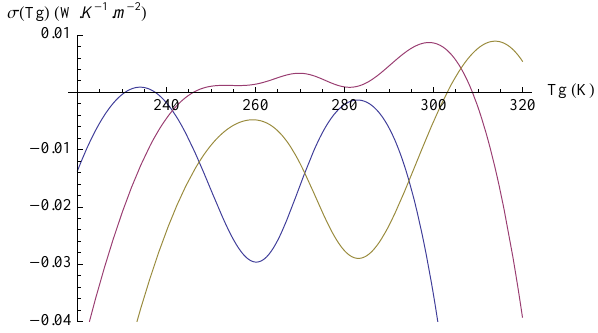
Fig. 8. Entropy production rate as a function of the surface tem- perature T g for the 0D model with ice-albedo feedback. For a low value of the solar constant ( S =0.8 S 0 , blue curve), there is only one local maximum with positive entropy production rate. The same holds for high solar constant ( S =1.2 S 0 , yellow curve), while there are three local maxima and two minima, all with positive entropy production rates, for S = S 0 (red